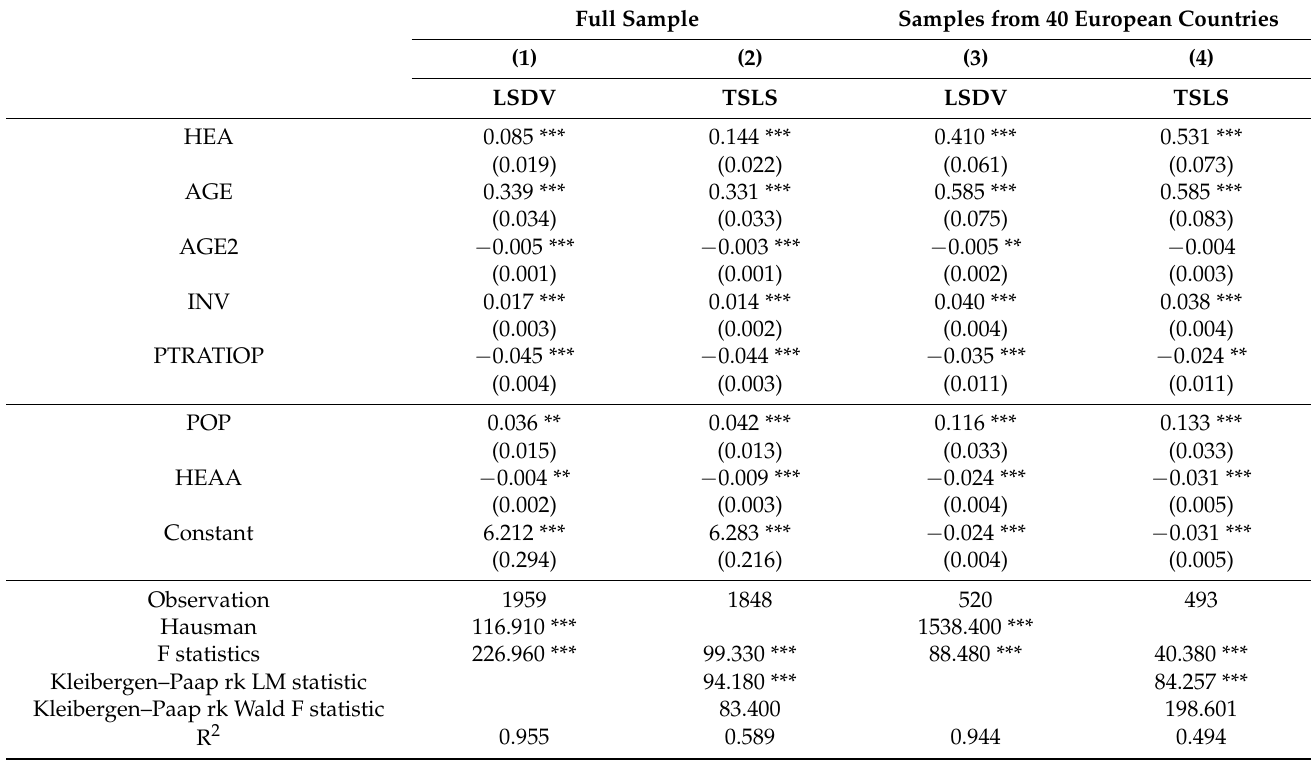
Table 6. Interaction between population aging and health investment on economic growth. Full